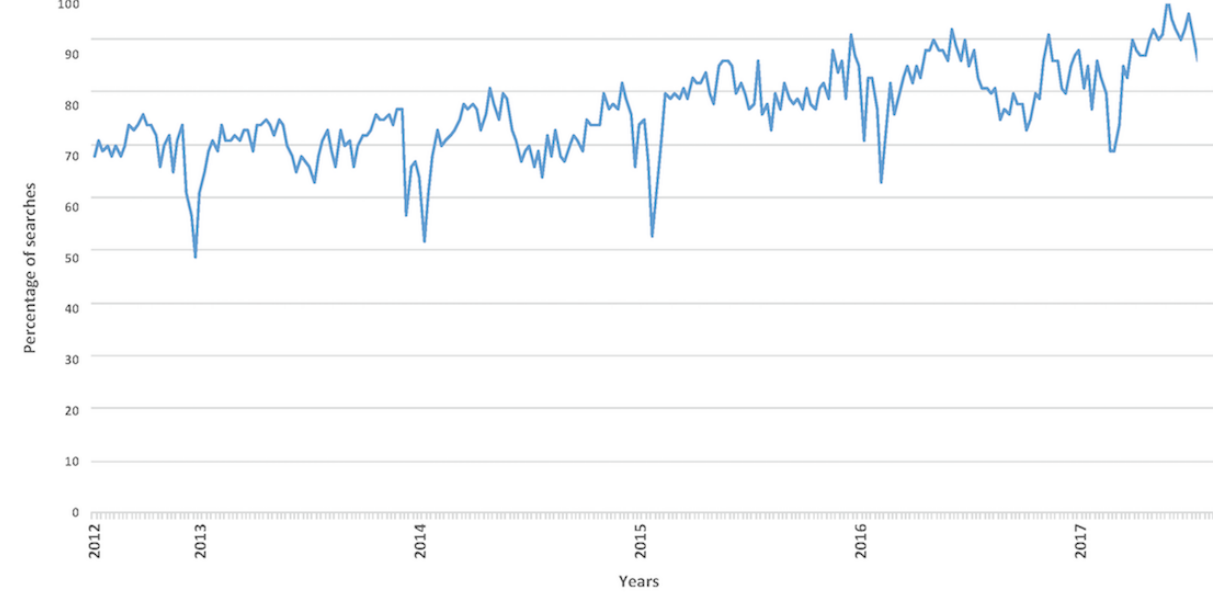
Figure 1. Interest over time in the term “chronic pain.” Results obtained through Google Trends. The values, expressed in percentages, reflect the number of searches done for the term relative to the total number of searches done on Google over